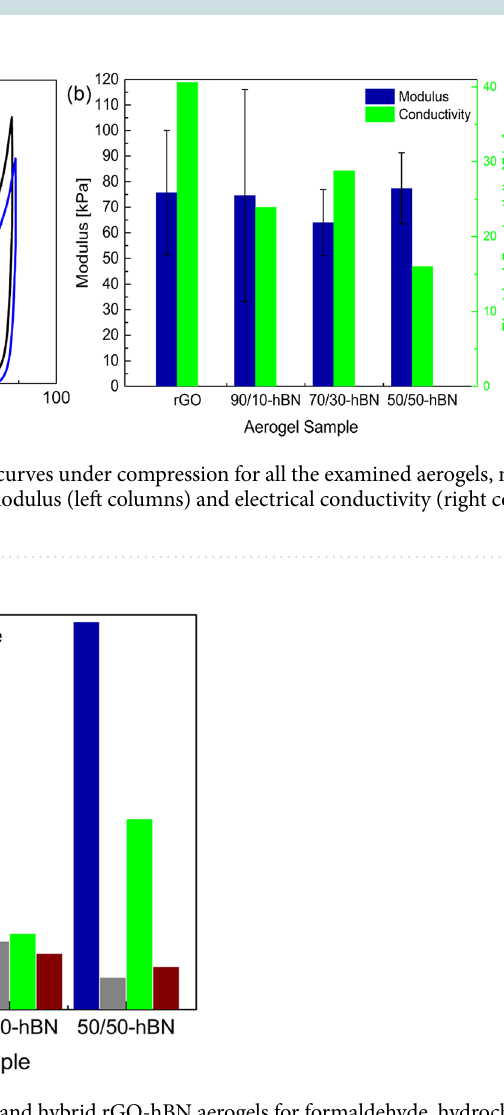
Figure 6. Absorption capacity of the rGO and hybrid rGO-hBN aerogels for formaldehyde, hydrochloric acid, humidity and acetic